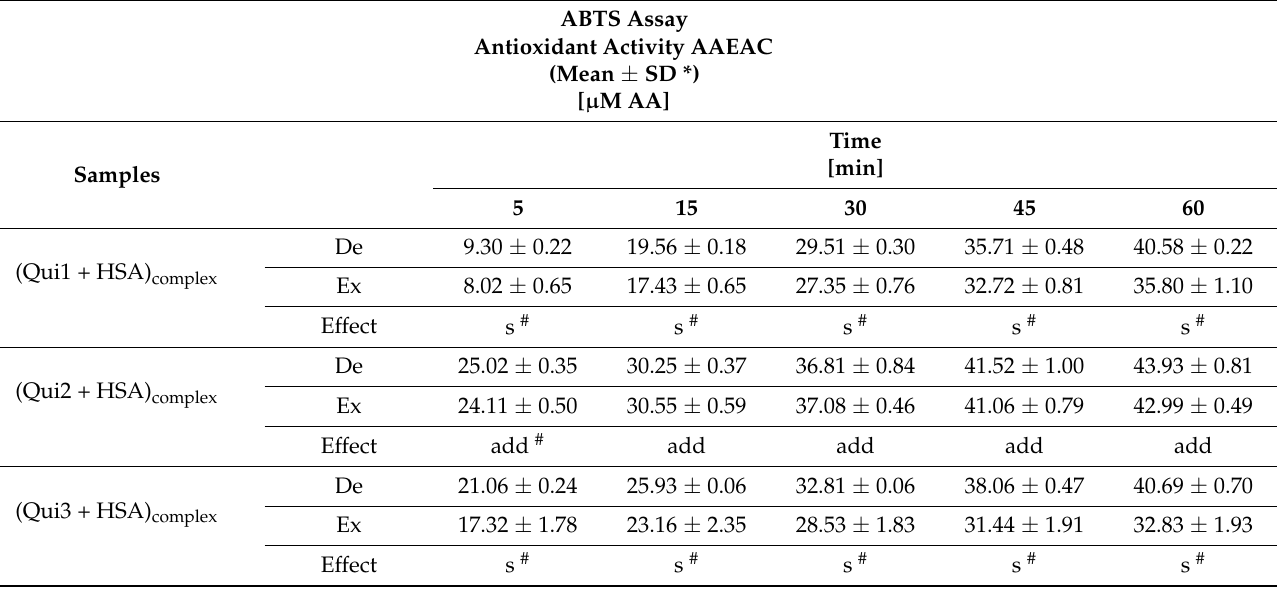
Table 9. Expected versus designated values of antioxidant activity AAEAC of the tested samples; ABTS